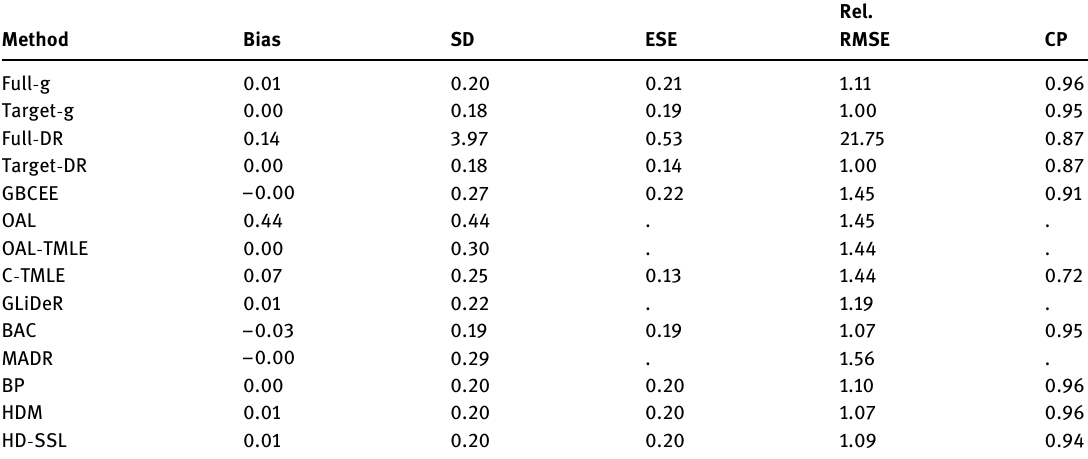
Table A9: Results of Scenario 2E ( misspeci fi cation of the outcome error distribution ) with n 200 =